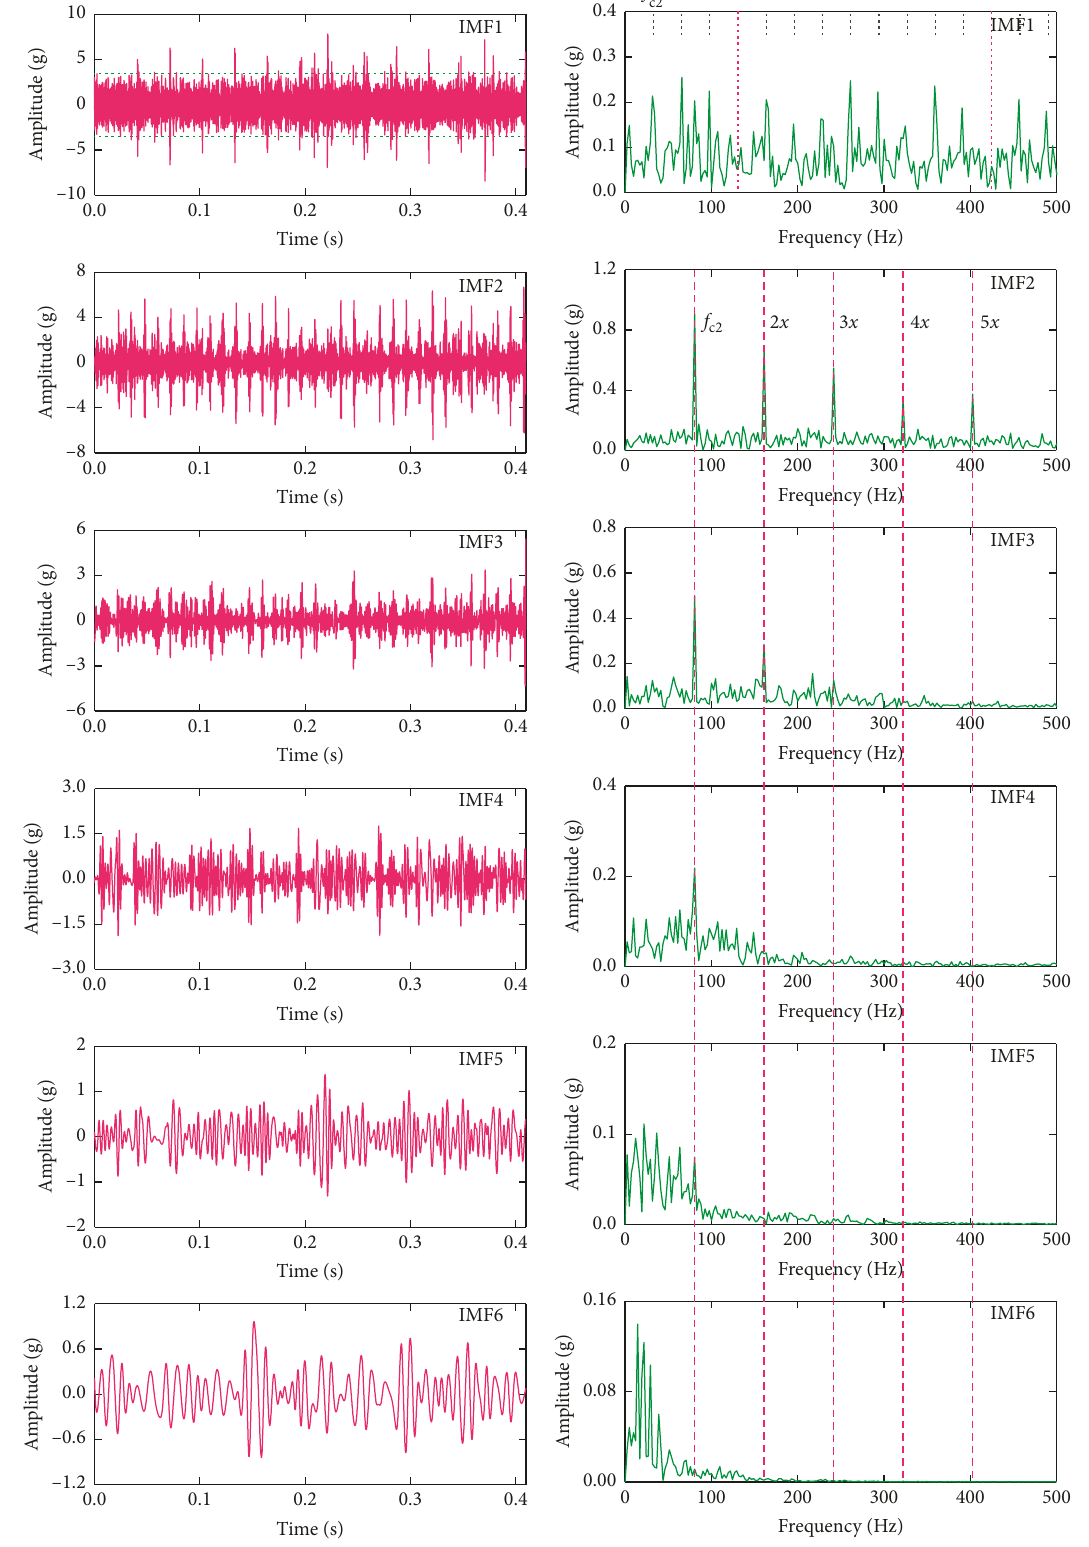
Figure 8: Results obtained using EEMD: (a) time-domain waveform; (b) Hilbert envelope spectrum of